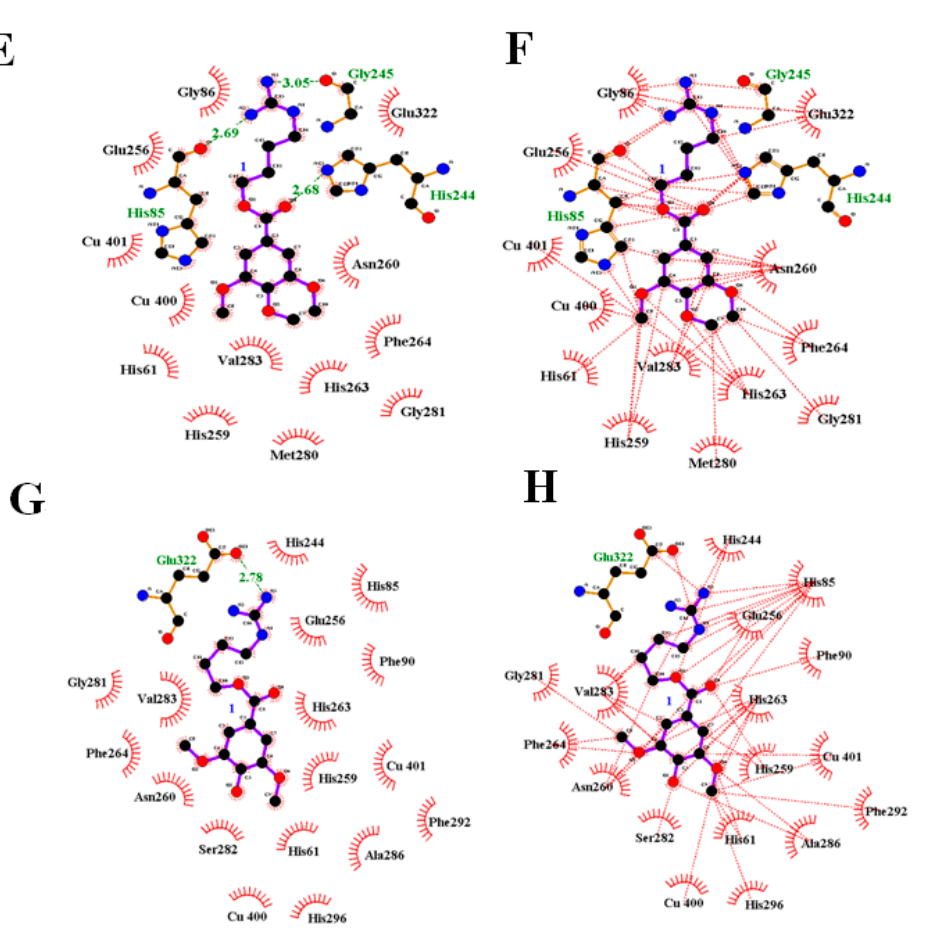
Figure 3. Cluster analysis of Autodock scores of inhibitors 1 and 2 into tyrosinase ( A , B ). The overlapped docking pose of the top 10 ranks ( C , D ). Hydrogen bonds ( 1 : ( E , G )) and hydrophobic interaction ( 2 : ( F , H )) at the best pose of the two docked into the catalytic site. The lowest Autodock score ( − 6.83 kcal / mol) for 10-methoxy-leonurine ( 1 ) revealed three hydrogen bonds with His85 (2.69 Å), His244 (2.68 Å), and Gly245 (3.05 Å) and hydrophobic interactions with 16 amino acids. In the simulation, leonurine ( 2 ) (Autodock score of − 6.16 kcal / mol) maintained a distance of 2.78 Å from Glu322 and interacted with 10 residues (Figure 3E–H, Table 2). Table 2. Autodock scores and hydrogen bonds of the top 10 ranks between tyrosinase and inhibitors. 1 2 Ranks Autodock Score Hydrogen Bonds (kcal / mol) Ranks